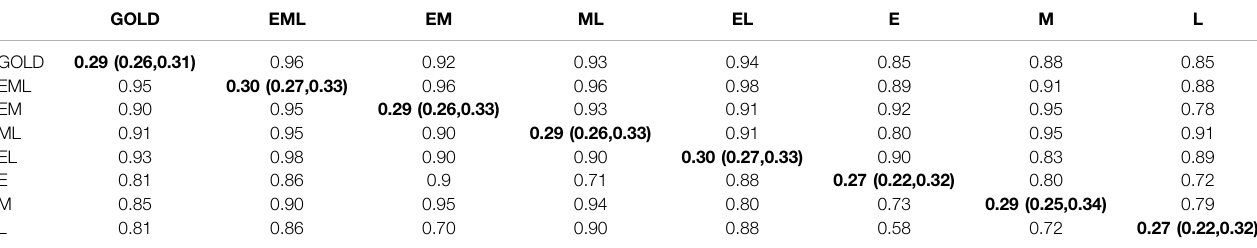
TABLE 1 | Comparison across censorship scenarios for simulated “ age at puberty ” phenotypes. Correlations between phenotypes ( n = 4,935) (white shading, below diagonal), correlations between EBVs ( n = 4,935) (grey shading, above the diagonal), and heritabilities with 90% credibility intervals (bold, on the diagonal). In the control scenario (GOLD), the phenotypes represented those that would be obtained when animals were observed daily. Censored scenarios simulate if animals in a herd were observed at either one, two or three visits. In the fi rst censored scenario, three herd visits (early, mid and late; EML) were simulated for each herd. In the second to fourth censoredscenarios,herdvisitswererestrictedtojusttheearlyandmid(EM),midandlate(ML),orearlyandlate(EL)visits.Inthe fi fthtoseventhcensoredscenarios,herd visits were restricted to one per herd, with an early only (E), a mid only (M) or a late only (L) visit. 90% credibility intervals did not exceed 0.02 for any of the